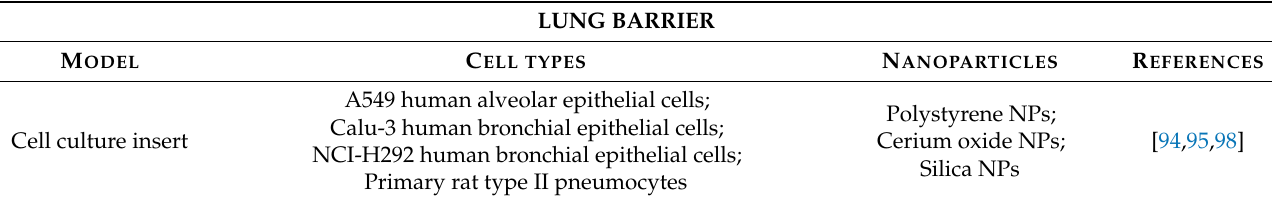
Table 4. Summary of in vitro lung barrier models used for nanomedical